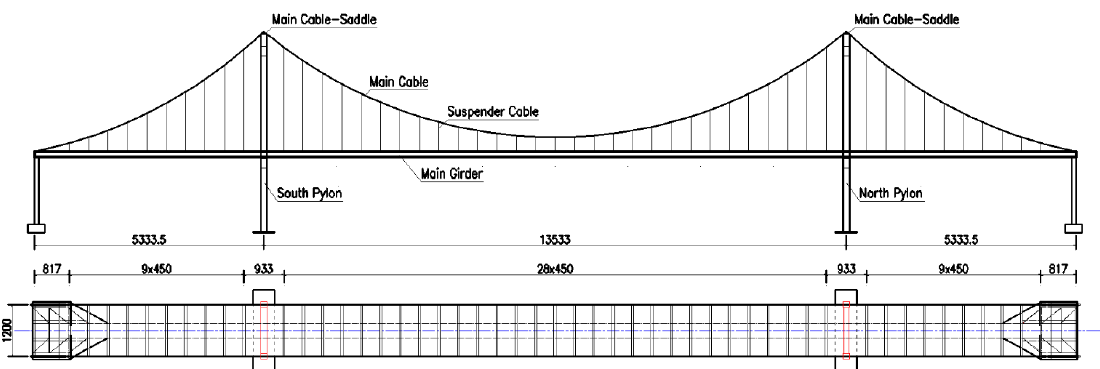
Figure 7. The construction diagram of test bridge ( total length of bridge is 24m , Units : mm ).